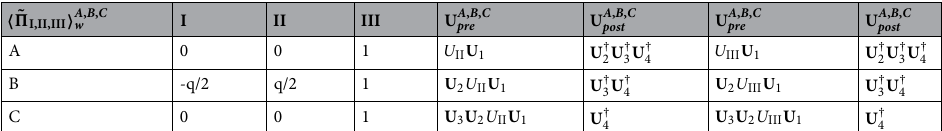
A , B , C (cid:31) I,II,III Table 2. Weak traces w Eq. (7) of a particle in a noisy Vaidman interferometer at � ˜ � different instants A , B , C indicated in Fig. 1 and corresponding pre-and postselections given by † respectively. † and ρ A , B , C U A , B , C U A , B , C U A , B , C U A , B , C (ρ out � � ) ρ A , B , C pre pre ( | ψ 0 �� ψ 0 | ⊗ | � �� � | ) [ pre ] post = post post ] ⊗ | �� | [ = (cid:31) (cid:31) (cid:31) (cid:31) U U is given in Eq. (15) with U given in Eq. (10). The effect of pure The quantity q = � | � + � | � + − ± decoherence indicated by U II occurs for path II (by U III for path III ) after beam splitter BS 1 .